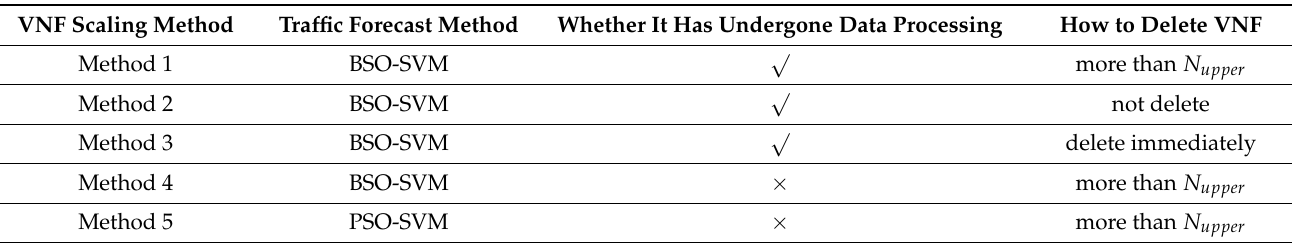
Table 4. Comparison of different scaling